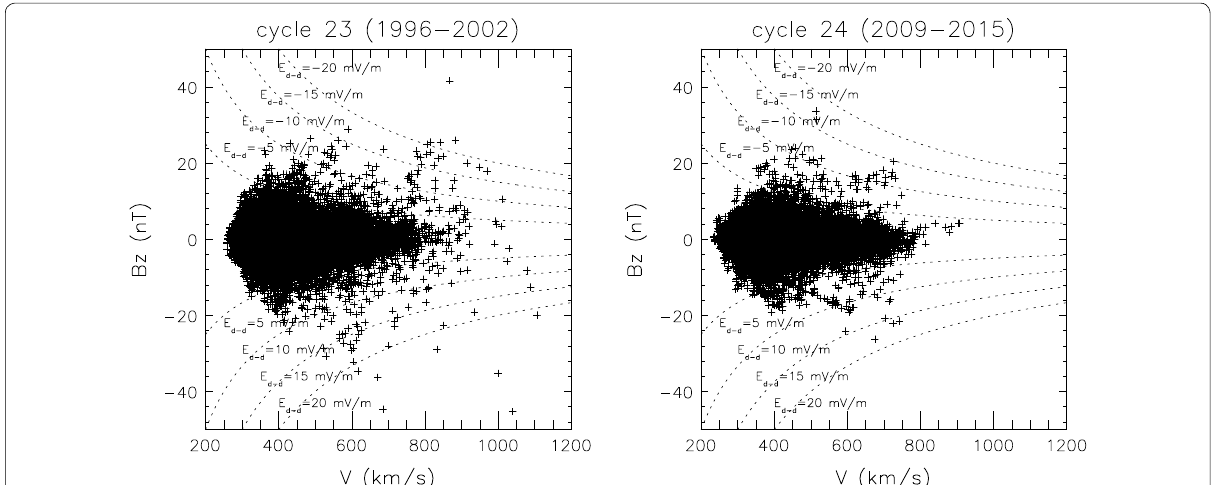
Fig. 5 Scatter plots of the 1-h averaged solar wind speed ( V ) and the north–south component of solar wind magnetic field (Bz). The left panel is for the rising–maximum phases of cycle 23 (1996–2002), and the right panel is for cycle 24 (2009–2015). The dotted curves show E d–d of and 20 mV/m, respectively ±